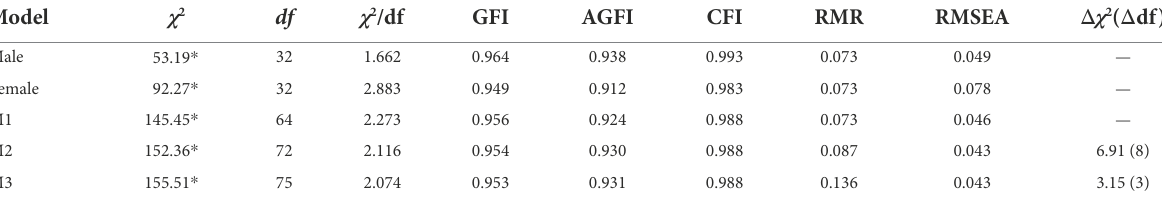
TABLE 4 Fit indices for measurement invariance of the ELB model across gender.